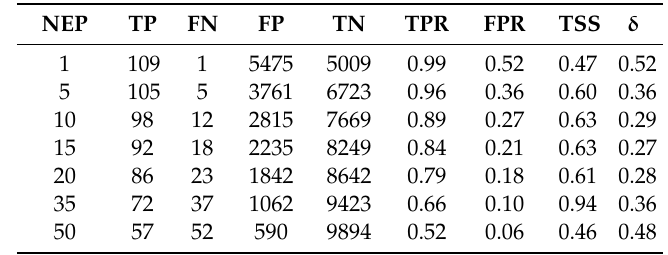
Table 2. Mean values of the performing indexes for calculated thresholds at di ff erent non-exceedance probability. The 15% threshold has the highest scoring indexes. NEP, non-exceeding probability; TP, true positive; FN, false negative; FP, false positive; TN, true negative; TPR, true positive rate; FPR, false positive rate; TSS, true skill statistics; δ , distance from perfect classification point. The optimal value for TPR and TSS is 1, while for FPR and δ is